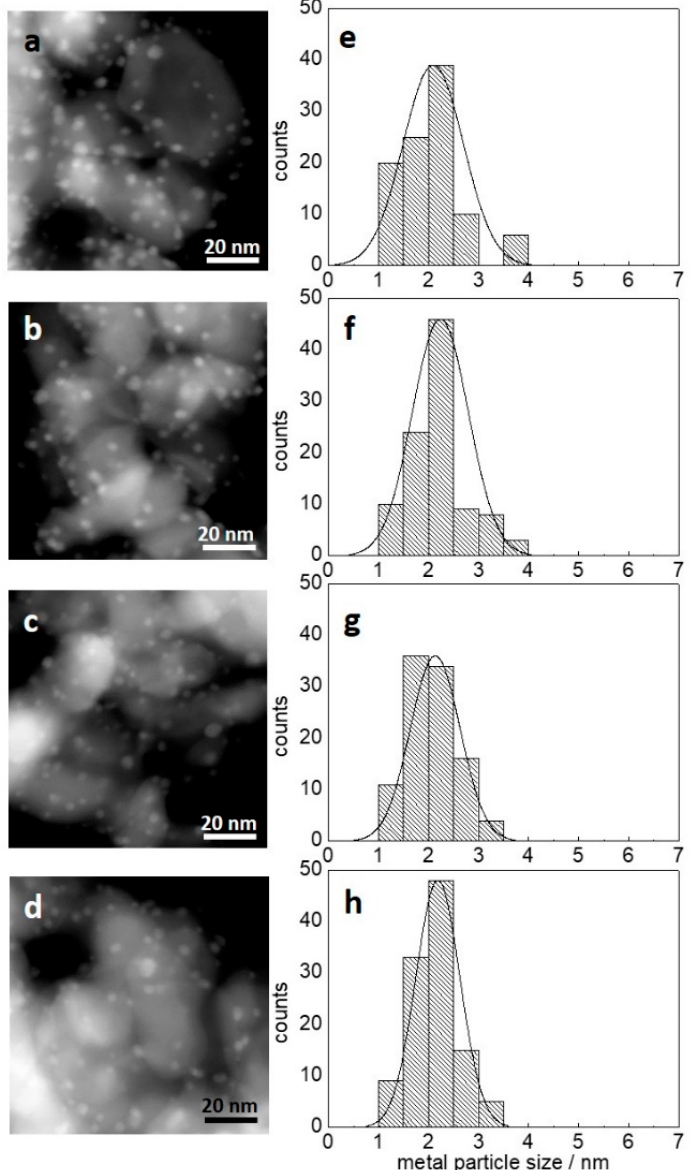
Figure 1. TEM images and size distribution profiles of ( a , e ) AuPd/TiO 2 , ( b , f ) AuPd-La(2:1)/TiO 2 , ( c , g ) AuPd-La(1:1)/TiO 2 , and ( d , h ) AuPd-La(1:2)/TiO 2 .